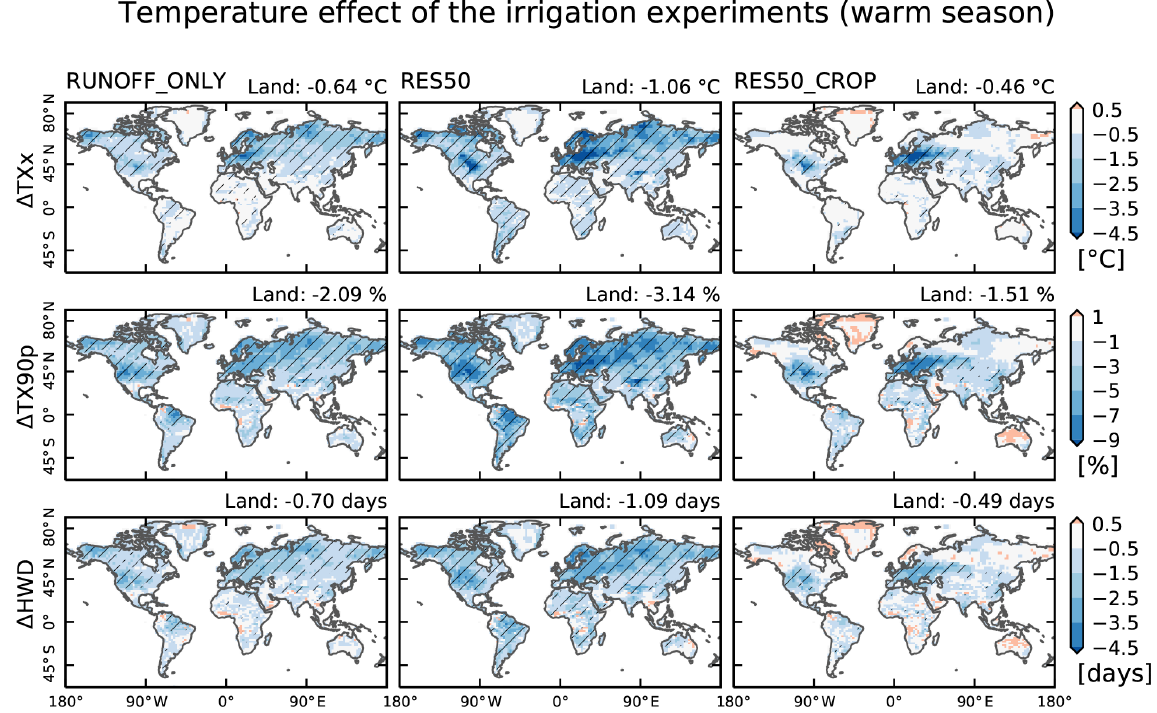
Figure 4. Difference between REF and RUNOFF_ONLY (left column panels), RES50 (central column panels), and RES50_CROP (right column panels) for temperature indices. The top row represents TXx (intensity), the middle row represents TX90p (frequency), and the bottom row represents HWD (duration). Hatching indicates significant grid cells (Wilcoxon–Mann–Whitney U test with a global p value of